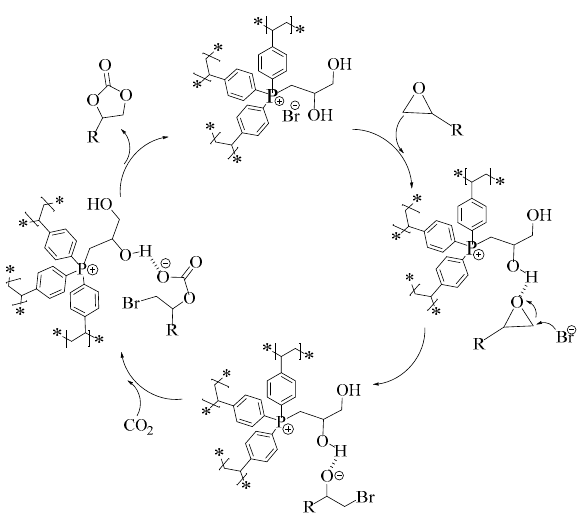
Figure 8. Proposed reaction mechanism for the cycloaddition of CO 2 to epoxides catalyzed by PQPBr ‐ 2OH.